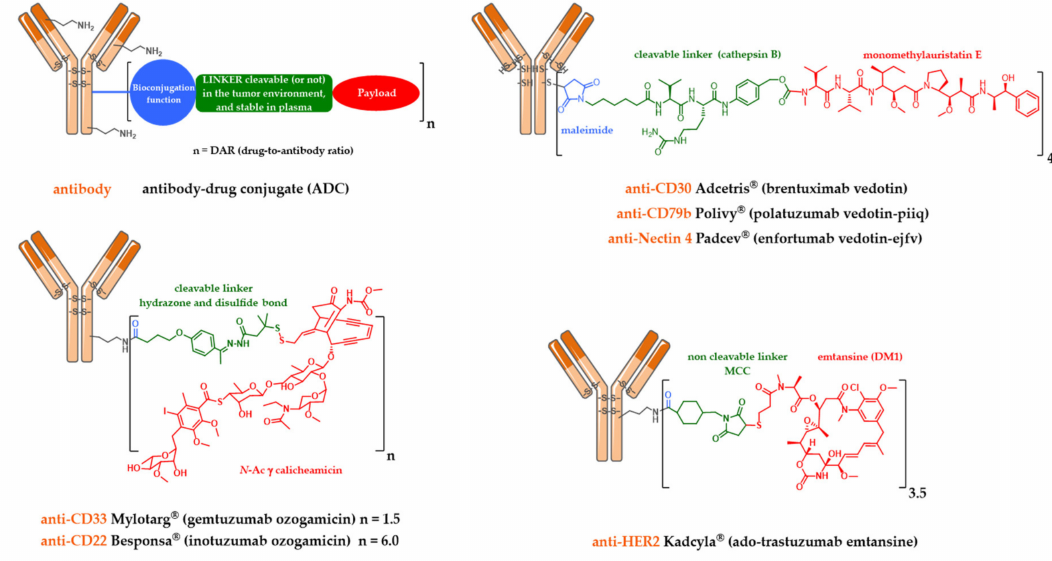
Figure 1. Schematic representation of the first and second generation FDA-approved ADCs: Mylotarg ® , Adcetris ® , Kadcyla ® , Besponsa ® , Polivy ® and Padcev ®